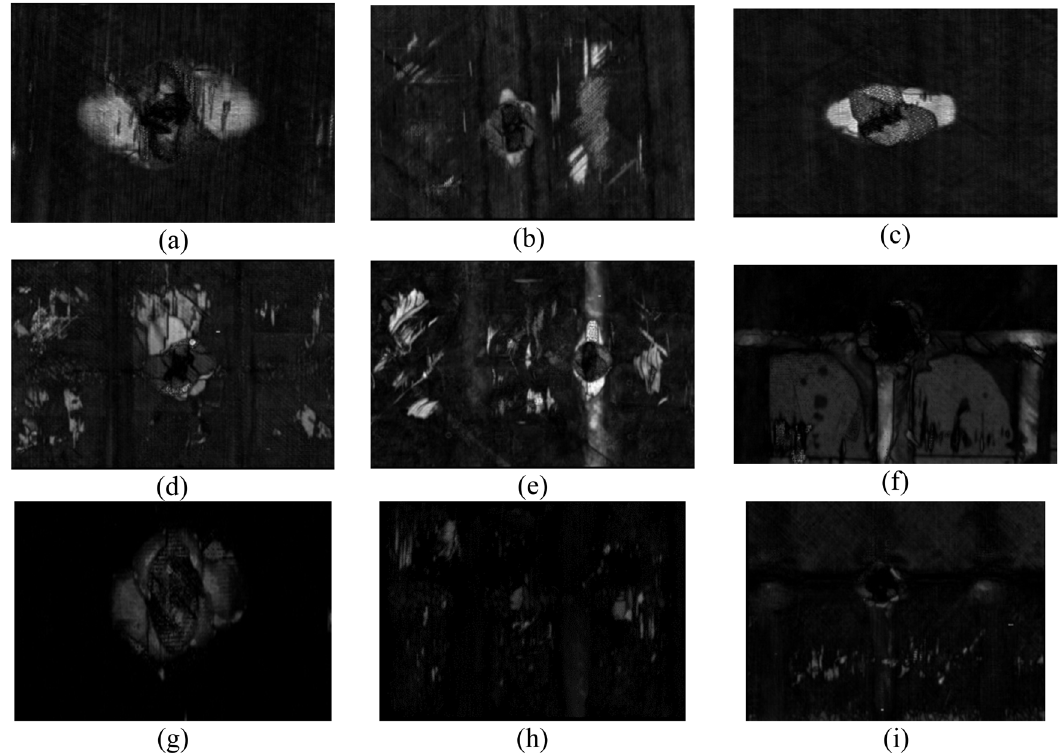
Figure 8: Internal impact damage: ( a ) 0d - P1; ( b ) 0d - P2; ( c ) 0d - P3; ( d ) 45d - P1; ( e ) 45d - P2; ( f ) 45d - P3; ( g ) 90d - P1; ( h ) 90d - P2; and ( i ) 90d -